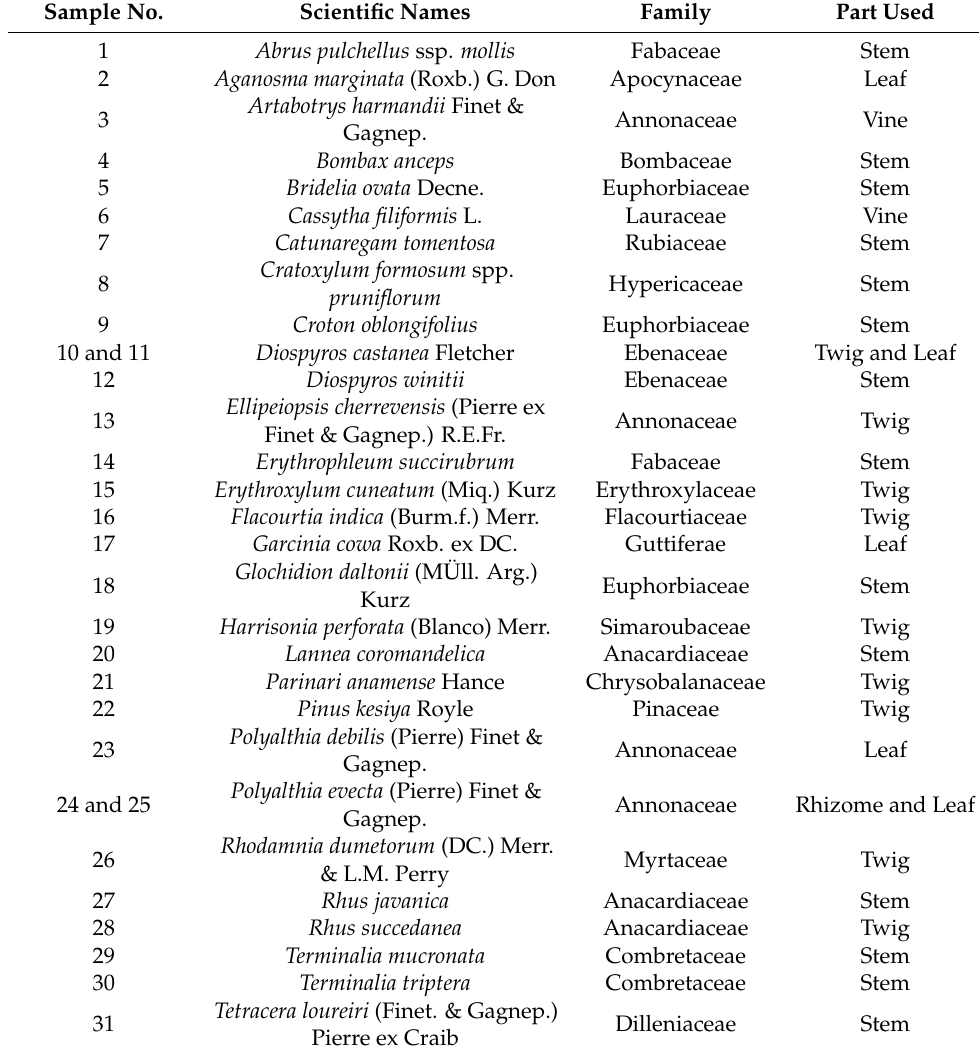
Table 1. Scientific names of Thai indigenous plants and parts used in this study. Sample